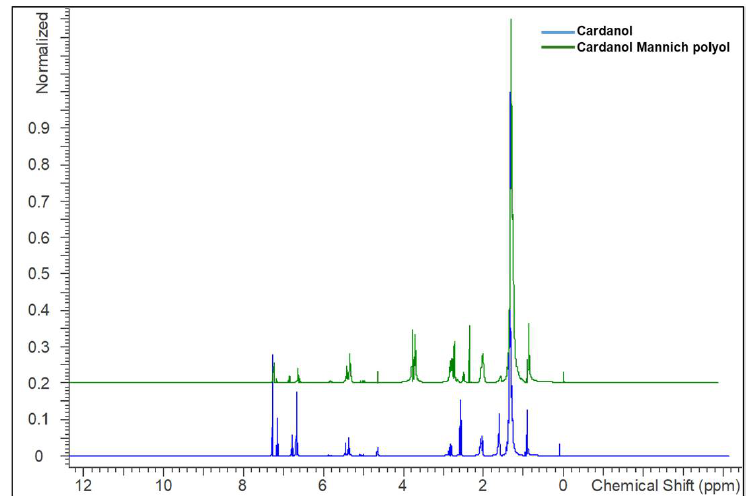
Figure 3. 1 H NMR of cardanol and cardanol Mannich polyol.